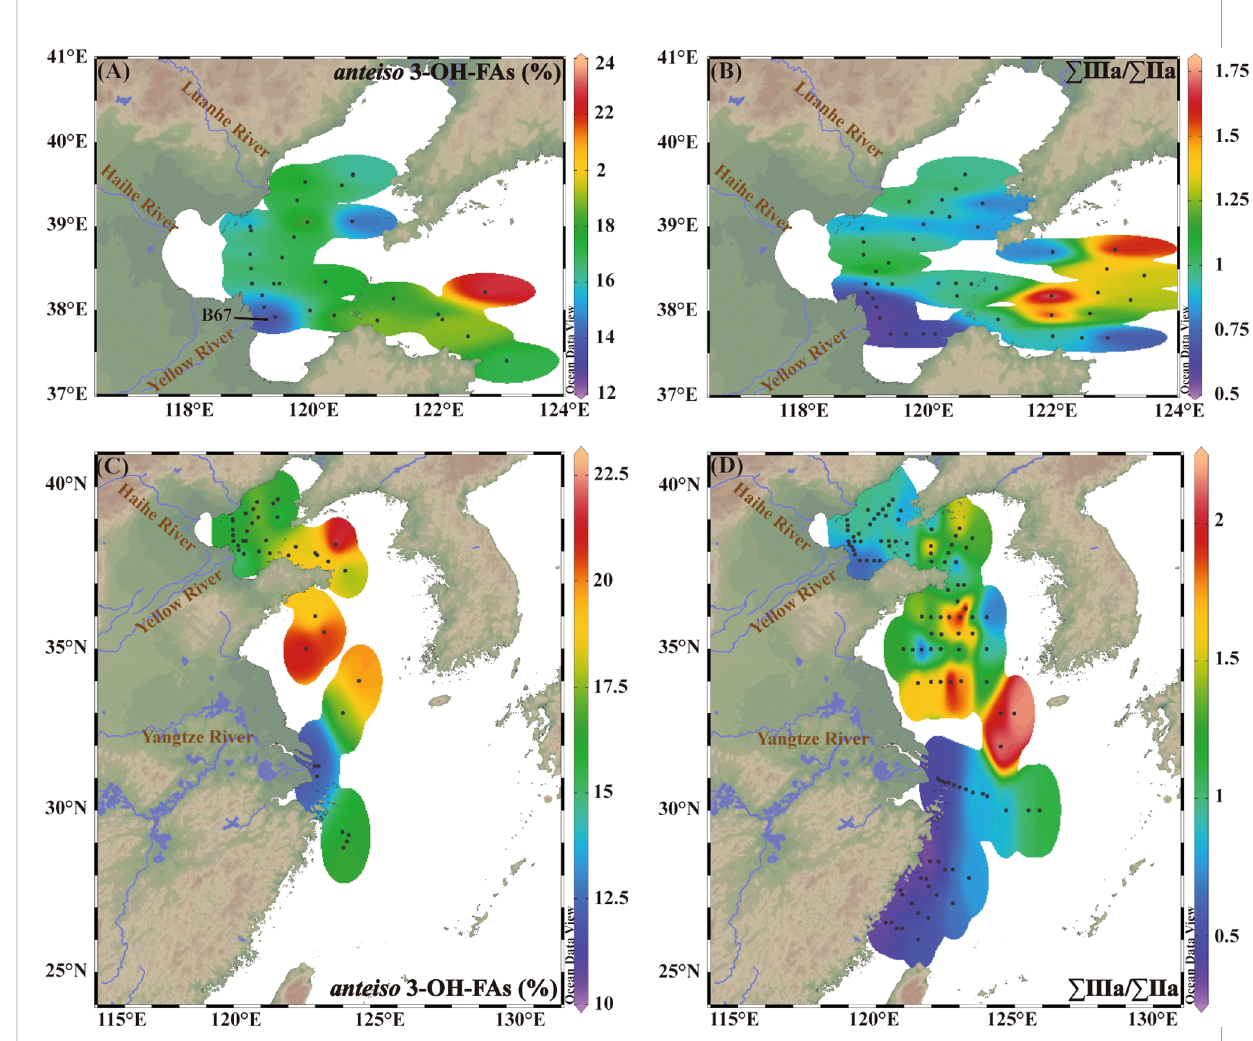
FIGURE 7 Spatial distributional patterns of fractional abundance of anteiso 3-OH-FAs (%) and ∑ IIIa/ ∑ IIa in the BS (A, B) and the northern China Marginal Sea (C, D) . 3-OH-FAs dataset (A, C) compiled from this study and Yang et al. (2020a). BrGDGTs dataset (B, D) are from Liu et al.